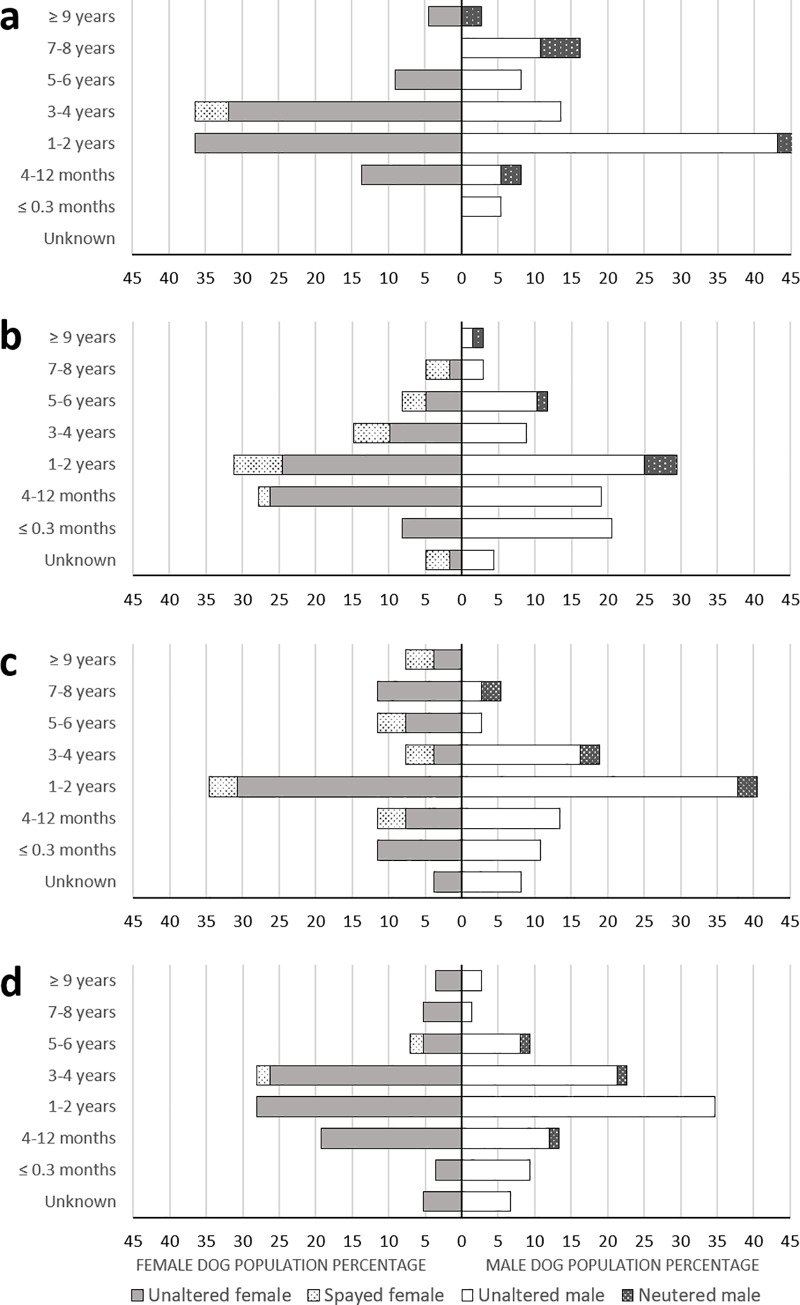
Age-sex population pyramid of owned dogs inhabiting urban RMSF low-risk (a), urban high-risk (b), rural low-risk (c), and rural high-risk (d) areas in and near Mexicali, Mexico.